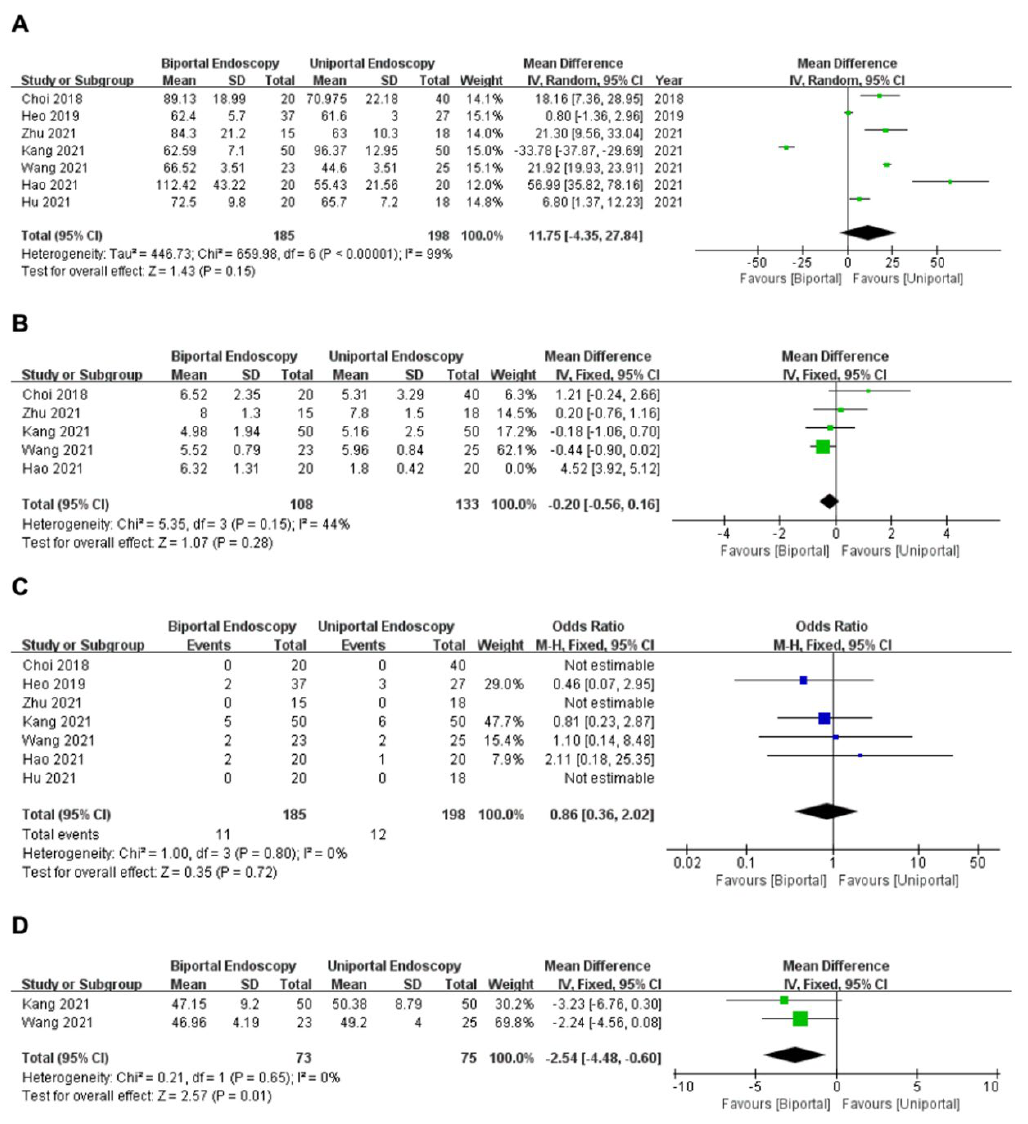
Figure 6. Forest plot ( A ) operation time; ( B ) length of hospital stay; ( C ) complication; ( D )